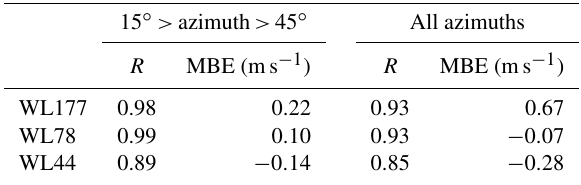
Table 2. Pearson correlation coefficient ( R ) and mean bias er- ror (MBE) between the sonic anemometer and the different lidars at ∼ 90m. On the left side, the measurements made in the azimuth range between 15 and 45 ◦ were